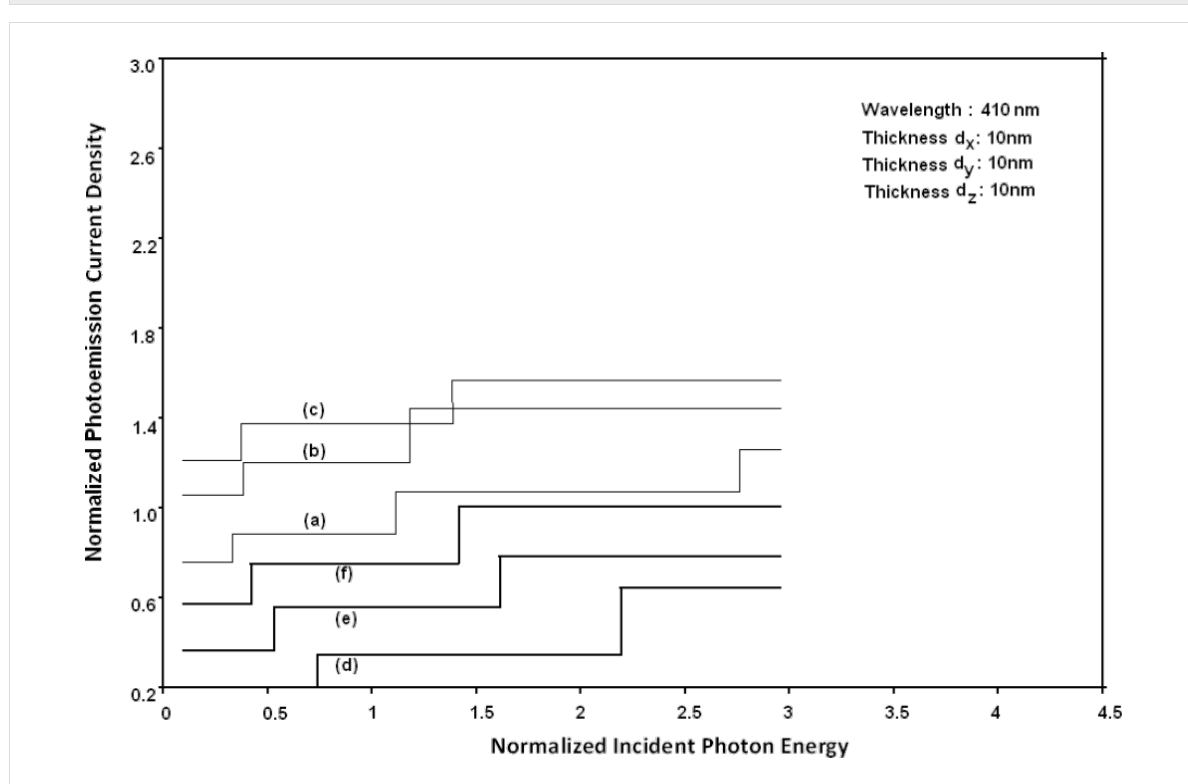
Figure 14: Plot of the normalized photoemission current density from quantum dot effective mass superlattices of HgTe/Hg 1 − x Cd x Te and In x Ga 1 − x As/ InP as a function of light wavelength for all cases of Figure 11.